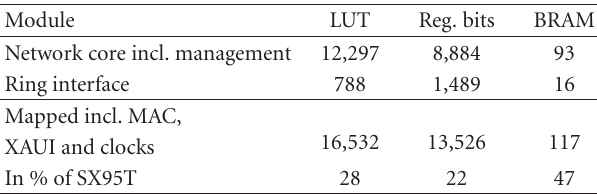
Table 1: Synthesis results for Master node components.